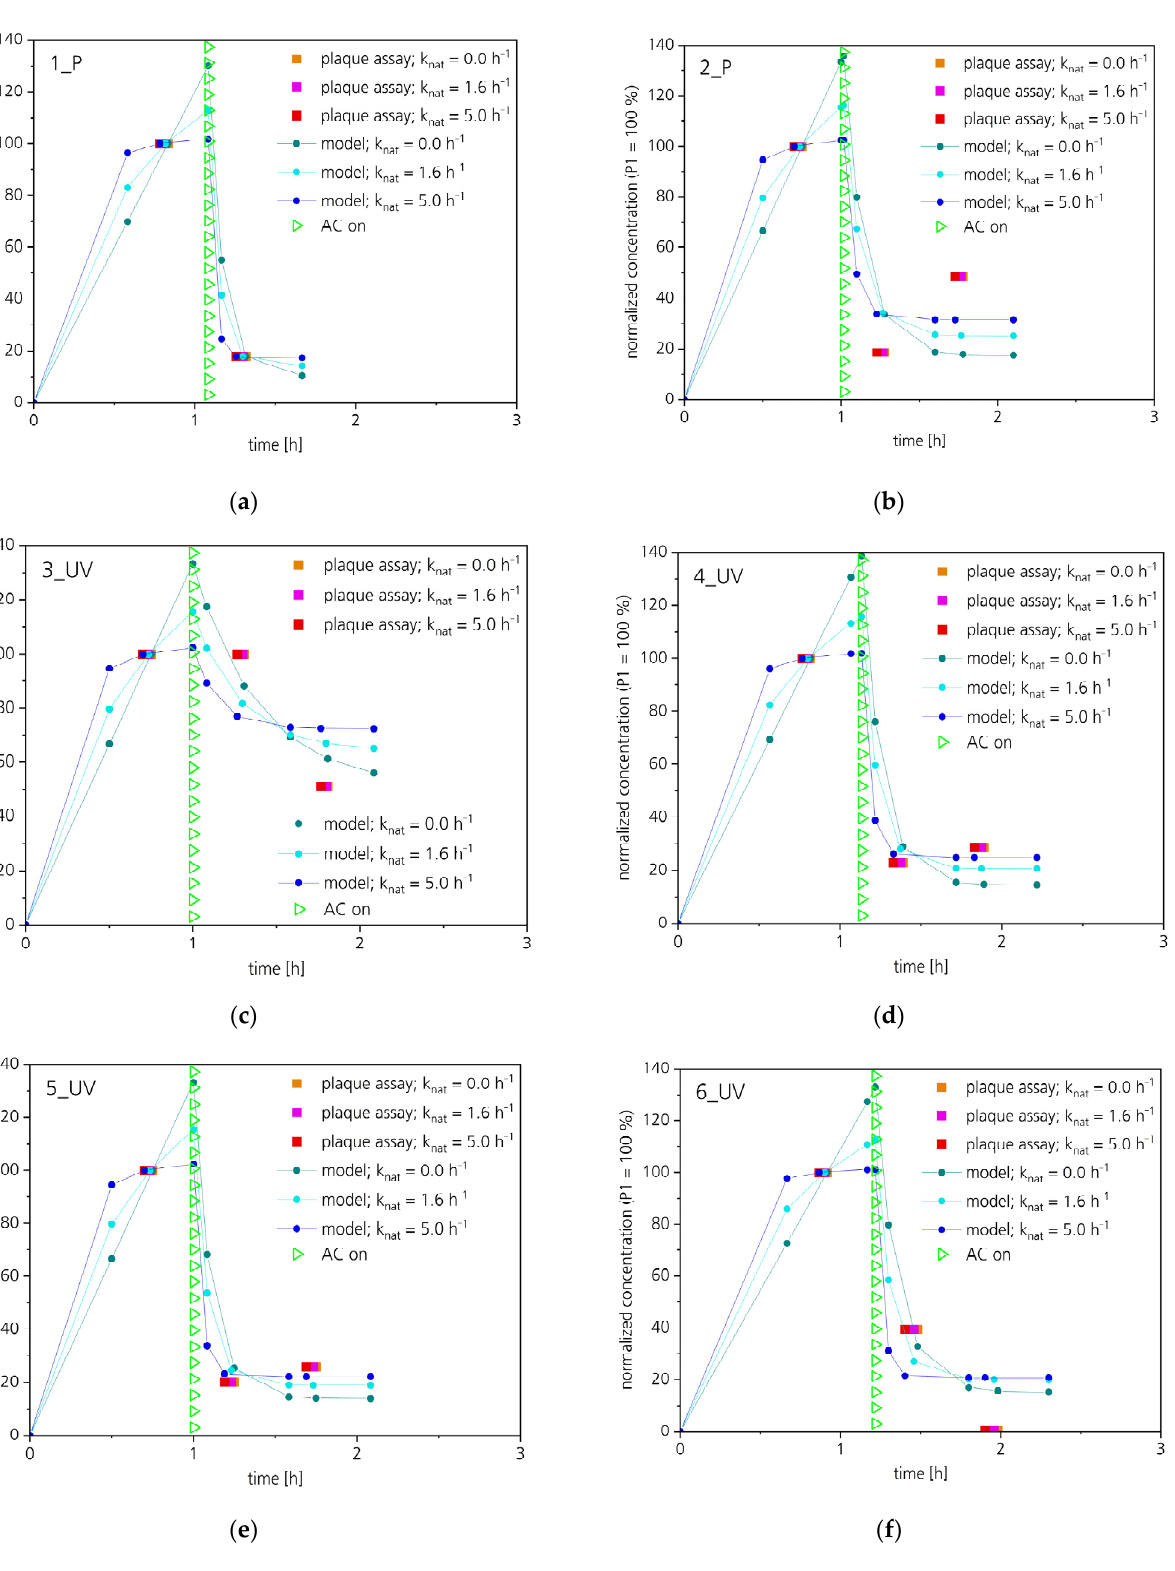
Figure 2. ( a – f ) Plaque assay fitting curves for the six measured air cleaners. Phi6 aerosol was released during the whole test procedure. An evaluation model based on Equation (1) was used for the calculation of the fitting